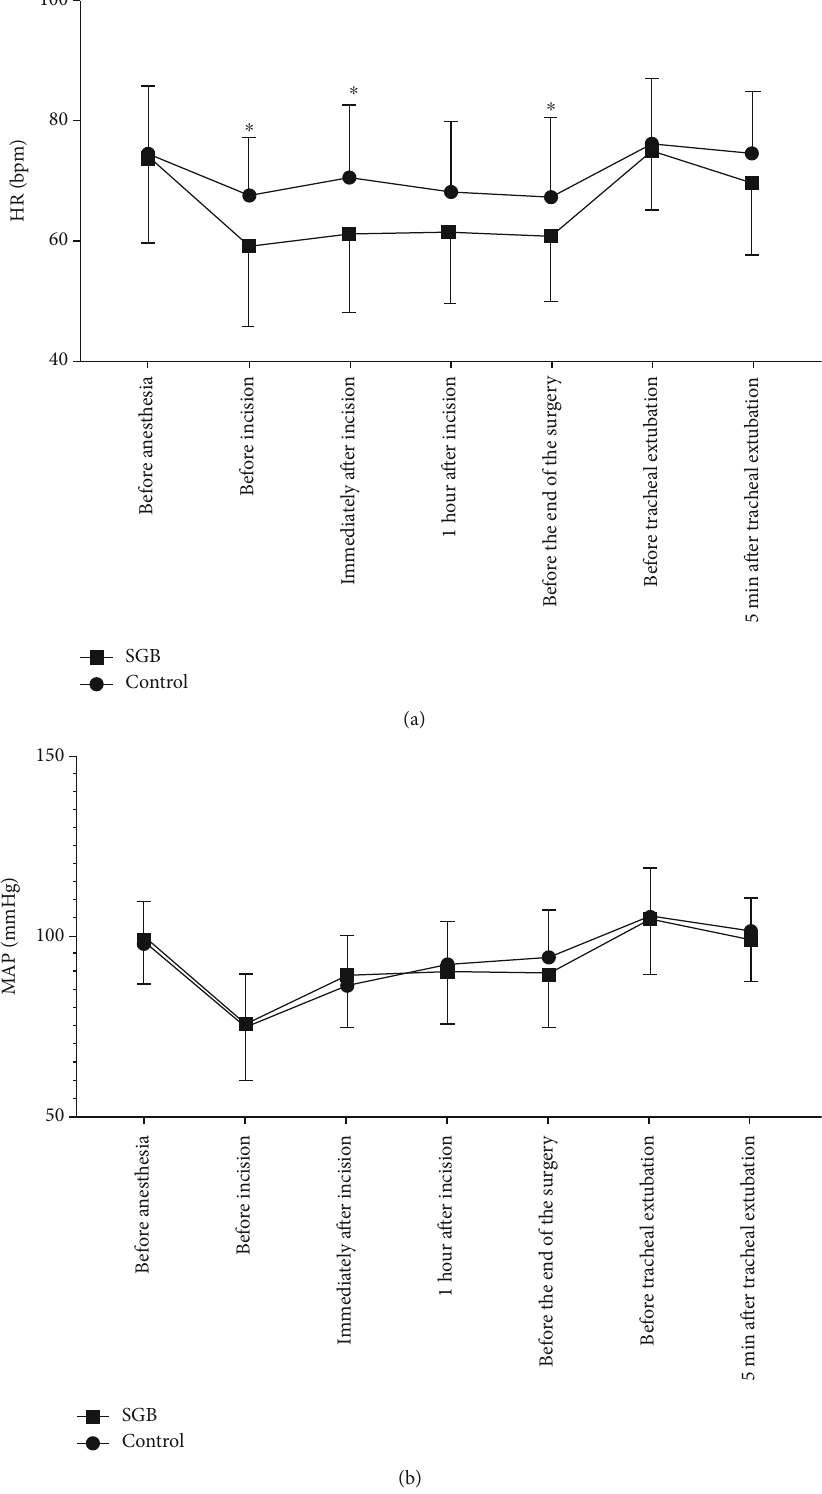
Figure 4: Hemodynamic changes perioperatively. (a) Heart rate (HR). (b) Mean arterial blood pressure (MAP). SGB: stellate ganglion block. Data are expressed as means ± SDs . ∗ P < 0 : 05 compared with PNB only